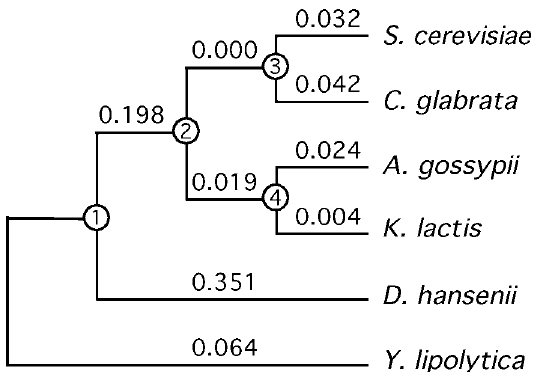
Figure 3. Branch-Specific Expected Number of Inversions per Gene The tree topology is deduced from Figure 1. The nodes are numbered from 1 to 4. Calculated inversion numbers are indicated on each branch of the tree. DOI: